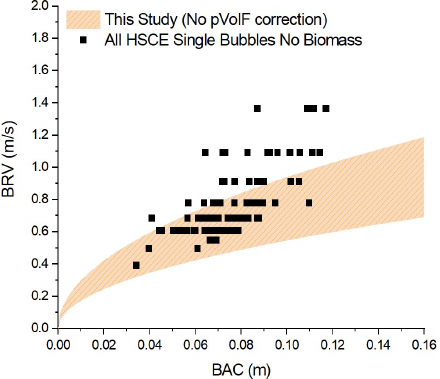
Figure 7. BRVs and BACs for single bubbles of all sizes, injected in the absence of biomass. Notes: (i) data points were obtained using the CREC-Optiprobes and the proposed HSCE model [19]; (ii) probabilistic predictive model (PPM) bands are set as proposed in the present study. The proposed PPM can be applied further to sand beds with different concentrations of biomass. Figure 8 reports the behavior of single bubbles in a sand bed with 5 vol% of biomass, as detected using CREC-Optiprobes, and calculated by employing the HSCE model. In this case, one can notice an improvement in both the BAC size and BRV velocity predictions, with most of the injected bubbles falling within the proposed PPM bands. One can also notice that the bubbles with the added 5 vol% of biomass are now, on average, smaller. This behavior is attributed to the ability of the biomass pellets to act as bubble breakers, reducing the BACs of the bubbles and, consequently, their associated BRVs. It is worth mentioning that the proposed PPM equation does not have a specific term to address the presence or absence of biomass pellets, with the ( (cid:101) IFC ) ratio in Equation (9) accounting for the bed changes due to the added biomass.